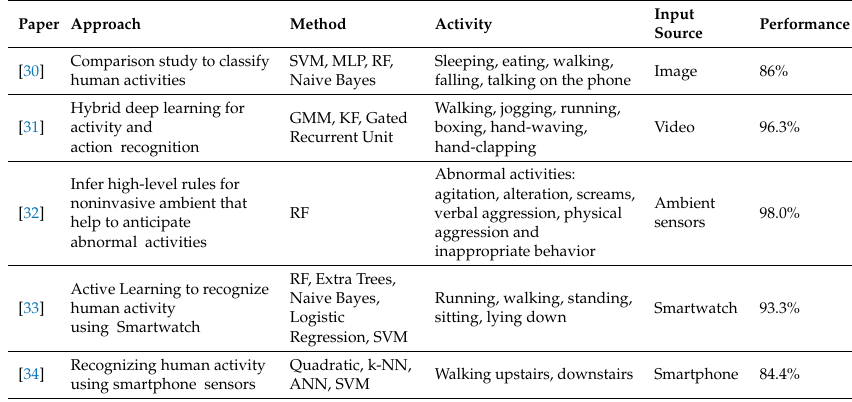
Table 1. Overview of activity recognition based on classical machine learning approaches. k-NN: k-Nearest Neighbor; SVM: Support Vector Machine; RF: Random Forest; MLP: Multi-Layer Perceptron; GMM: Gaussian mixture model; KF: Kalman